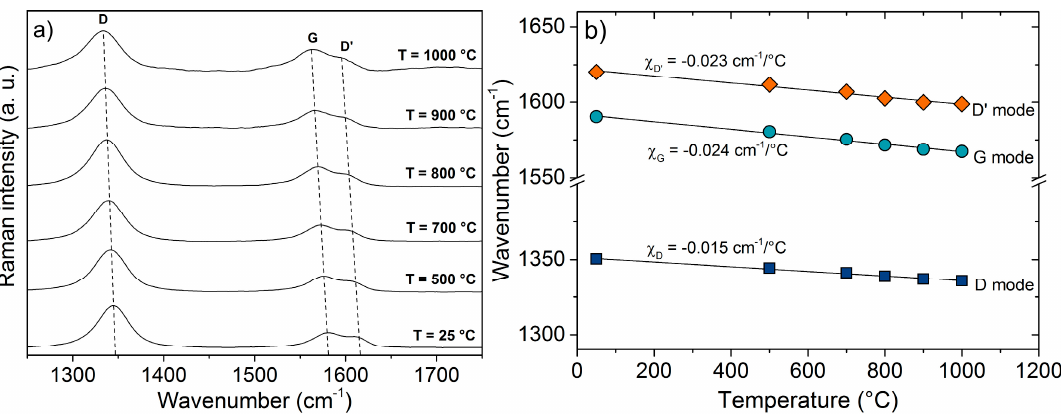
Figure 3. Temperature-dependent Raman spectra ( a ) and thermal coefficients of the Raman bands ( b ) of C-11.